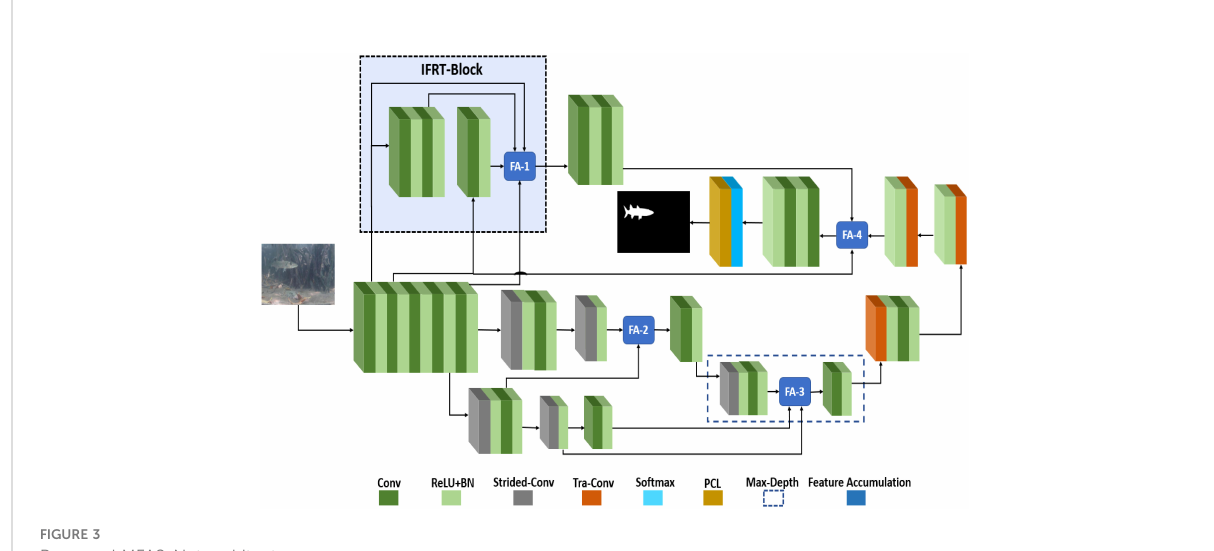
FIGURE 3 Proposed MFAS-Net